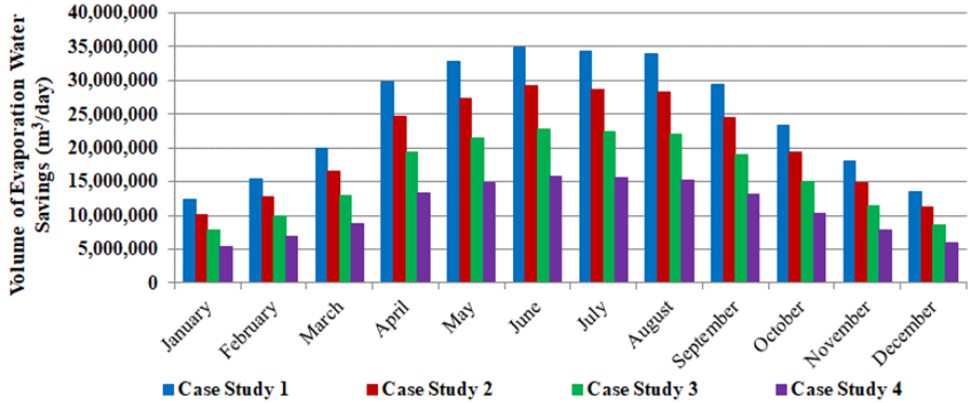
Figure 7. Average volume of daily water evaporation savings for each month of the year during the installation of FPV panels on Lake Nasser .